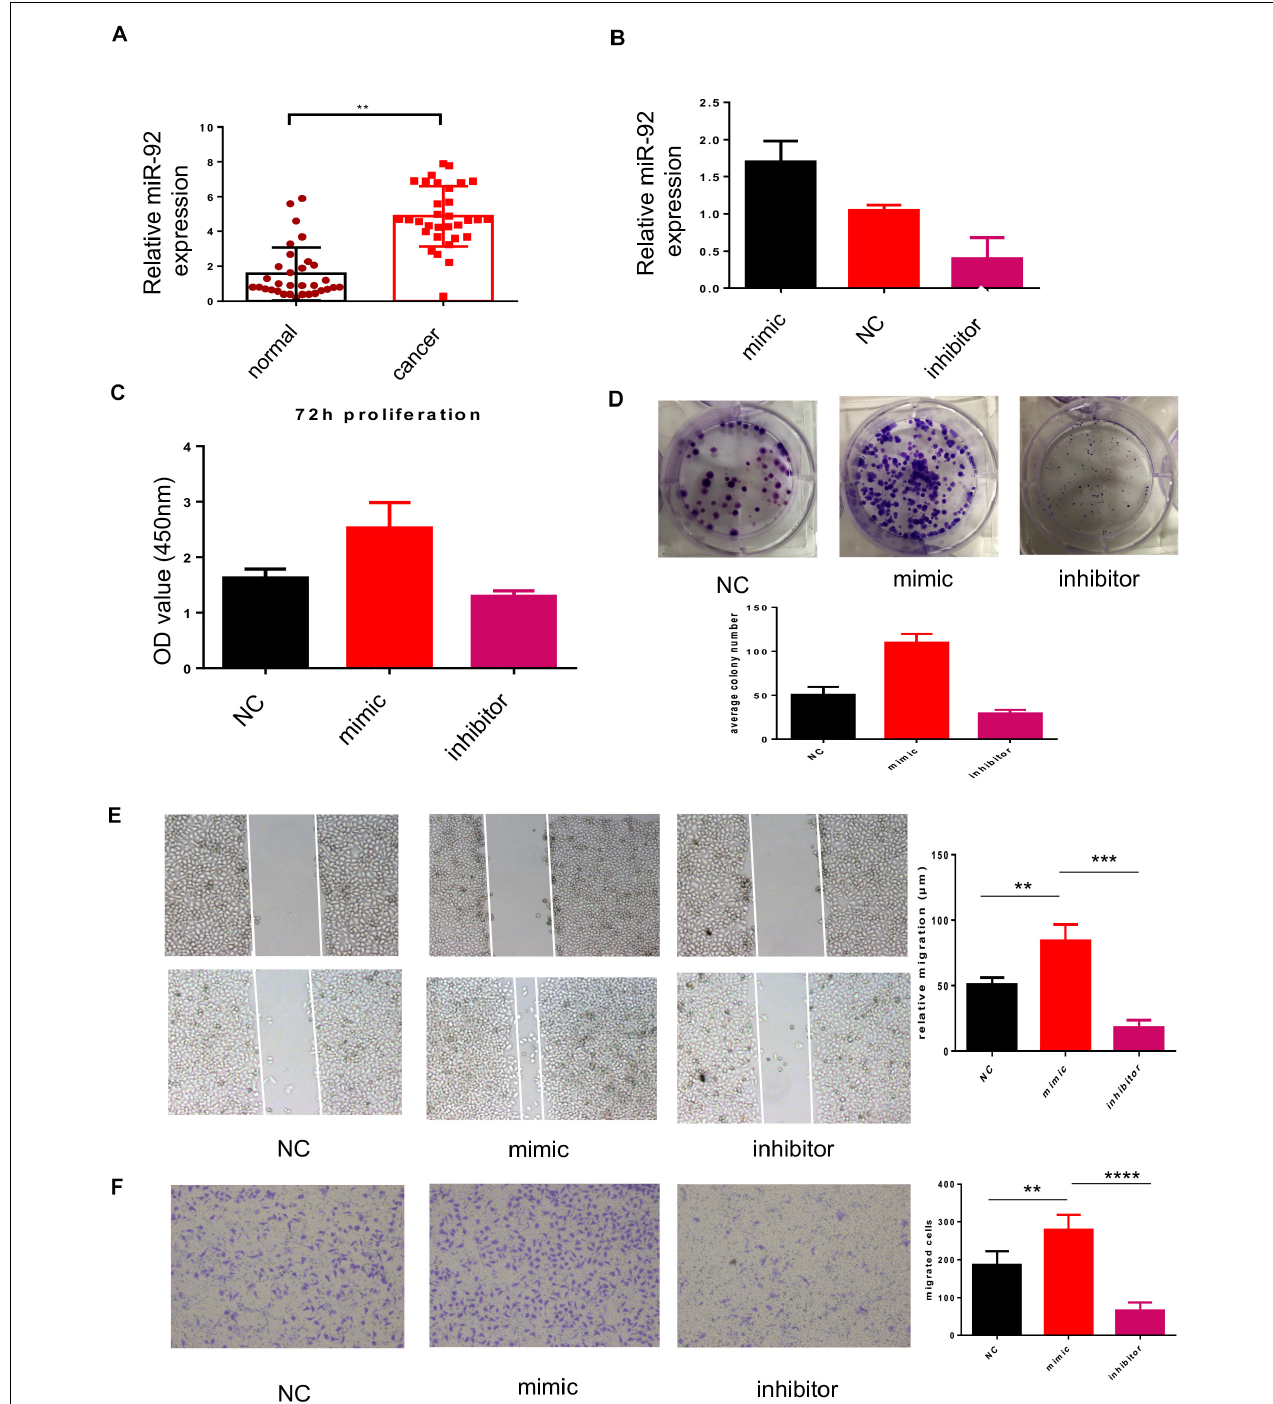
FIGURE 2 | miR-92 promotes migration and proliferation of breast cancer cells. (A) miR-92 expression was examined by qRT-PCR in human breast cancer tissue and normal tissue. In total, 32 cancer tissues and 34 normal tissues were analyzed. (B) miR-92 expression after transfection of miR-92 mimic or inhibitor was analyzed by qRT-PCR ( n = 3). (C) miR-92 overexpression promotes cell proliferation. Cancer cells were transfected with a miR-92 mimic or inhibitor and the absorption (A450 nm) was detected at 0, 24, 48, and 72 h, respectively. (D) Cancer cells transfected with the miR-92 mimic and NC control were assayed for clonogenicity in adherent cultures. (E) A wound-healing closure assay for cancer cells which transfected with the miR-92 mimic or inhibitor (magnification, × 50, scale bar: 500 µ m). (F) Transwell assay for cancer cells which transfected with the miR-92 mimic or inhibitor (magnification, × 100). Error bars represent mean ± SD; **** P < 0.0001; n.s., not significant; by paired two-sided Student’s t -test.